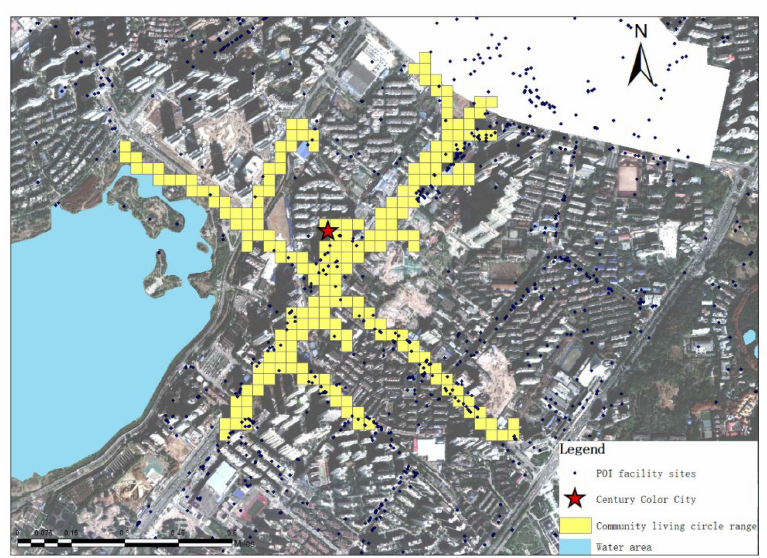
Figure 8. Century Color City 15 min-CLC